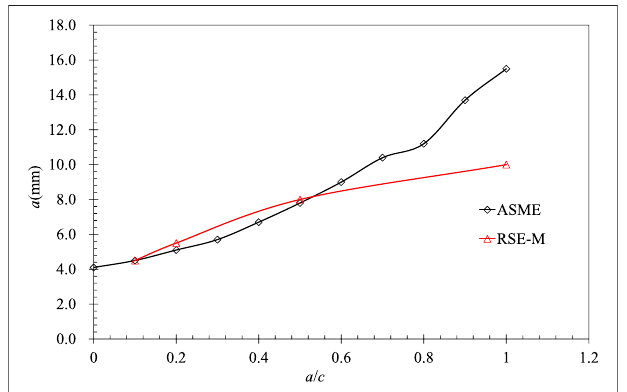
FIGURE 2 | Geometries for embedded